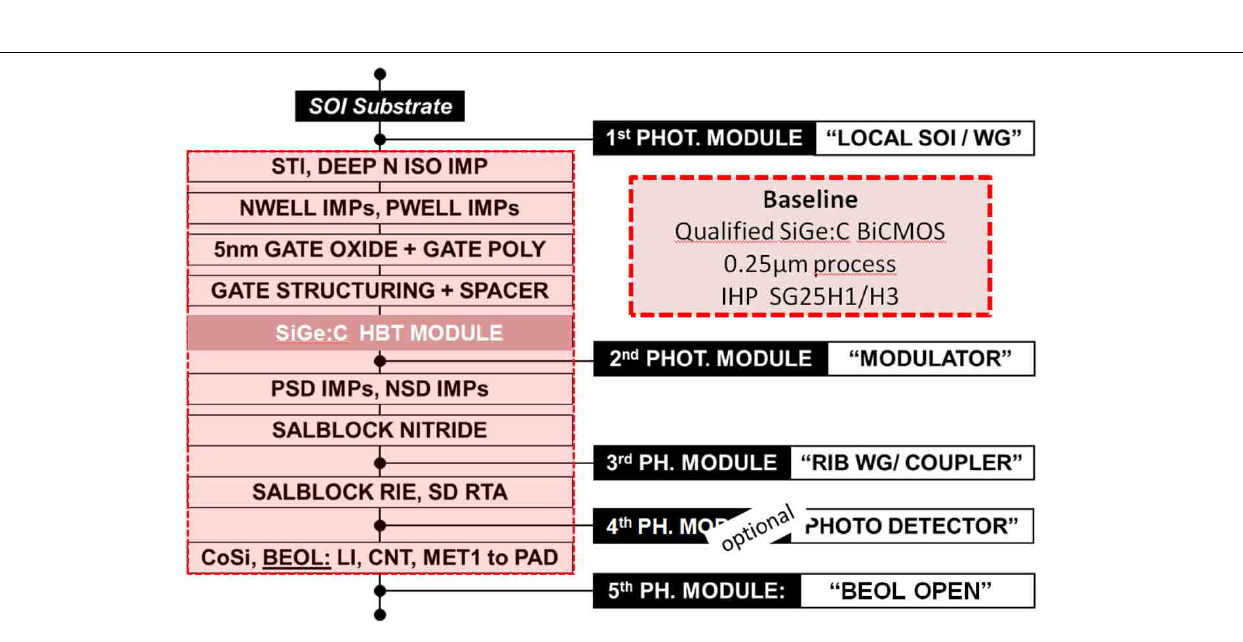
cross-sections of the phase-shifting diode in the photonic part and of a bipolar transistor in the electronic part are shown in the lower right.